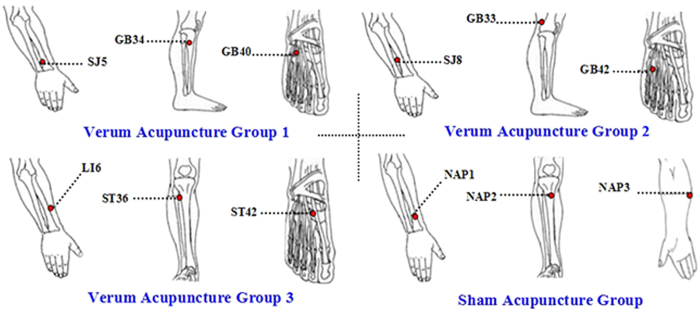
Acupoints location.